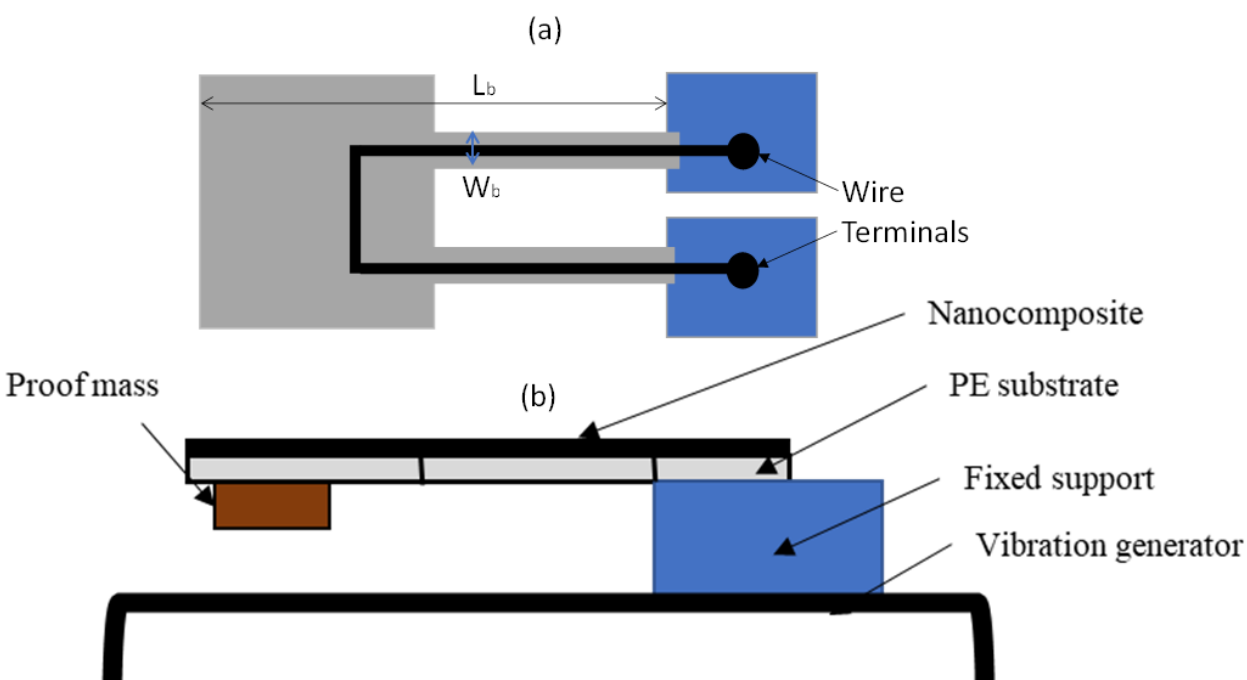
Figure 1. Accelerometer and experimental setup. ( a ) Top view and ( b ) side view of